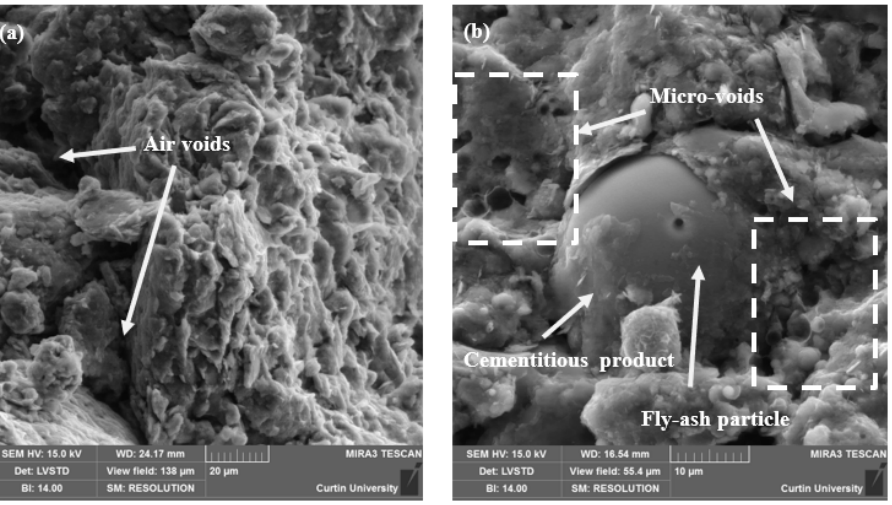
Figure 12. SEM of clay samples: ( a ) untreated clay; and ( b ) geopolymer-treated clay cured at 28 days.